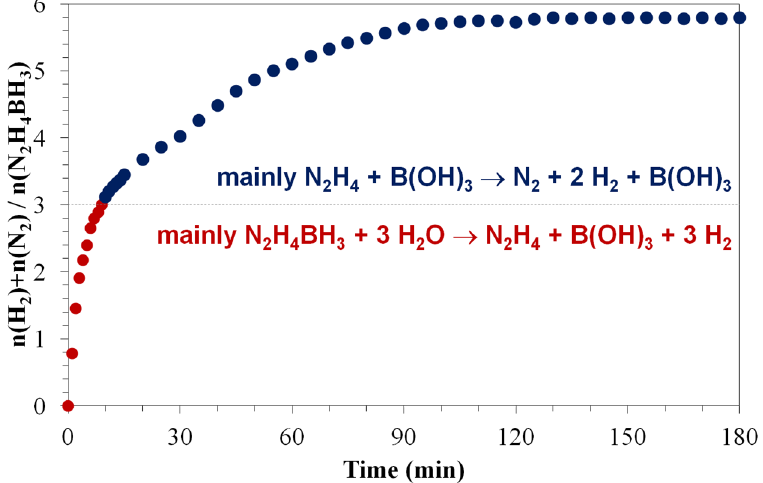
Figure 4. Stepwise catalytic dehydrogenation of aqueous hydrazine borane in near-room conditions and in the presence of Ni 0.89 Pt 0.11 nanoparticles. The gas evolution is composed of a first step, i.e. , fast hydrolysis of the BH 3 group, followed by a second one, i.e. , slow dehydrogenation of the N 2 H 4 moiety. Adapted from Ref. [46] with permission from The Royal Society of